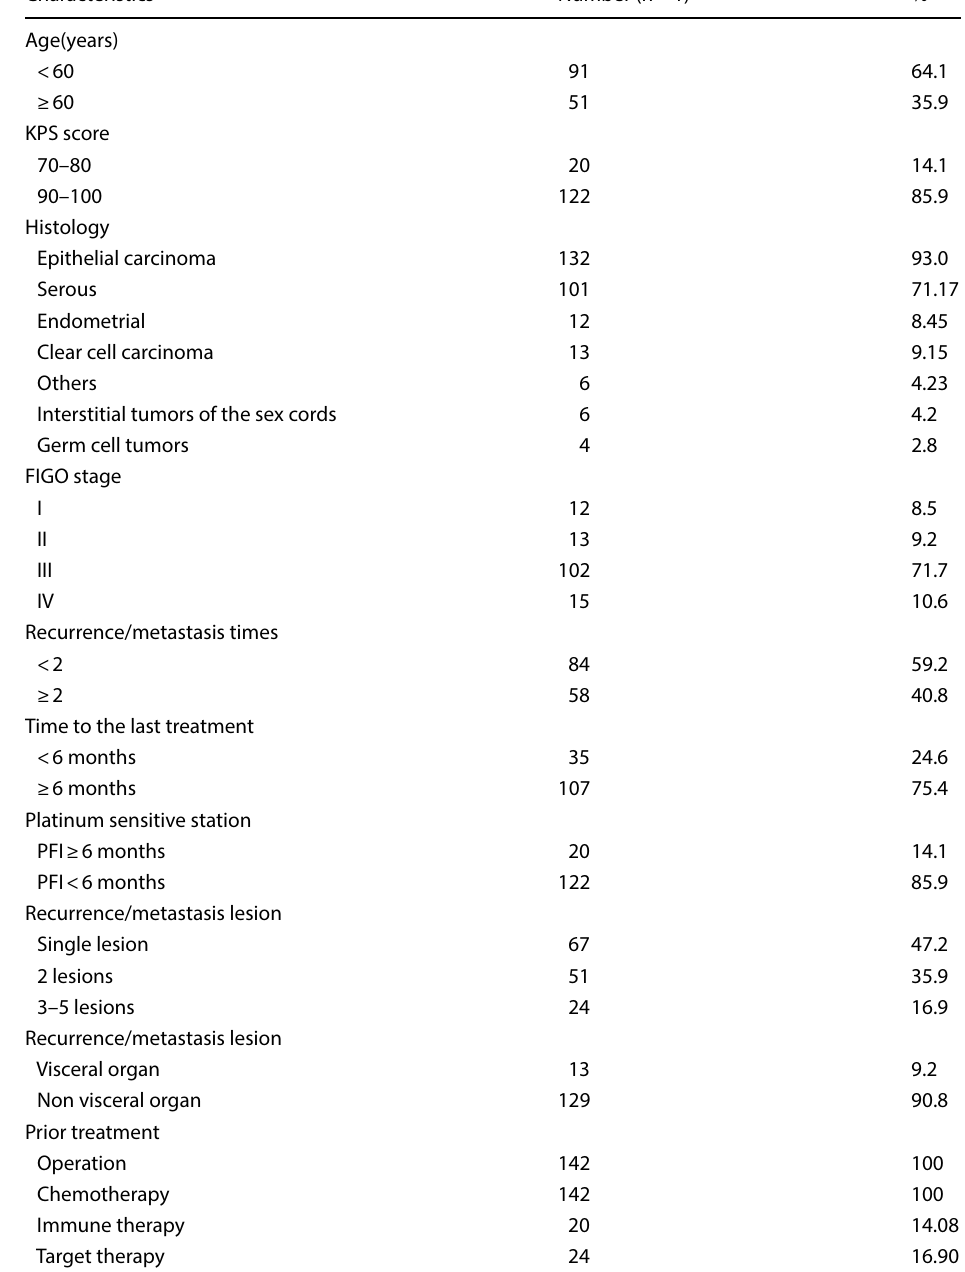
Table 1 Baseline and clinical characteristics of the patients